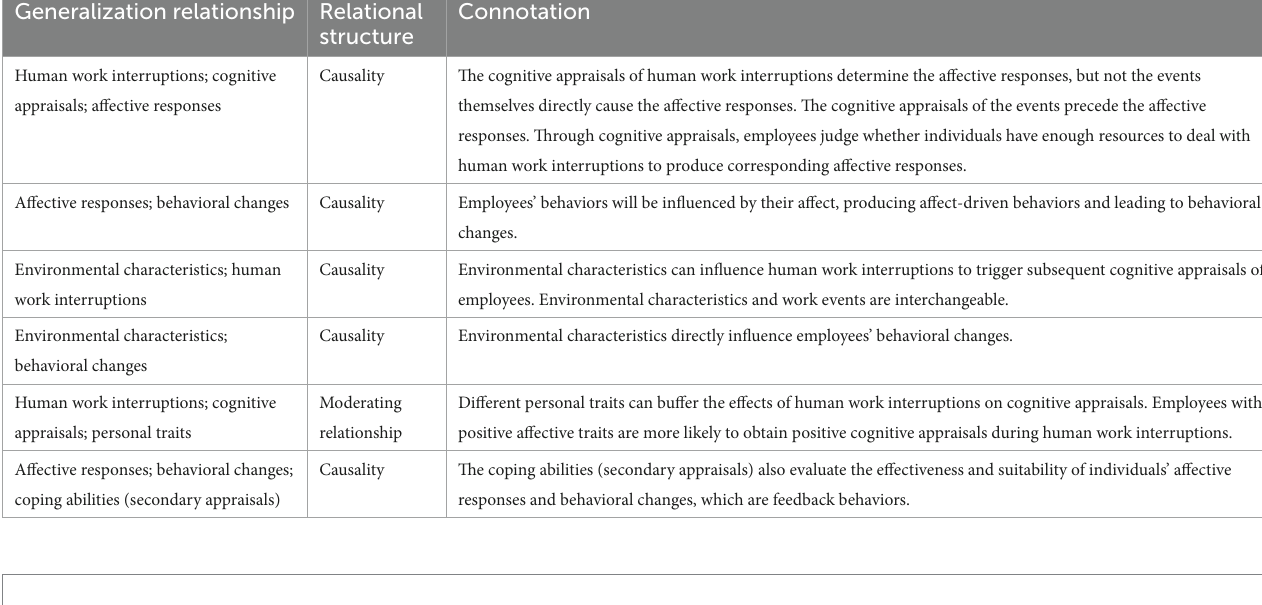
TABLE 3 Human work interruptions selective